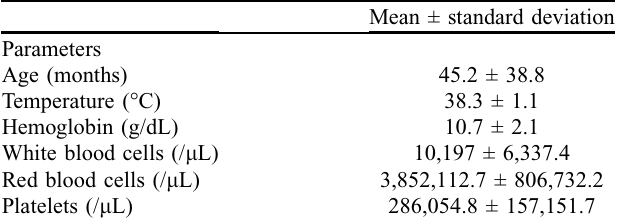
Table 2. General characteristics of the included